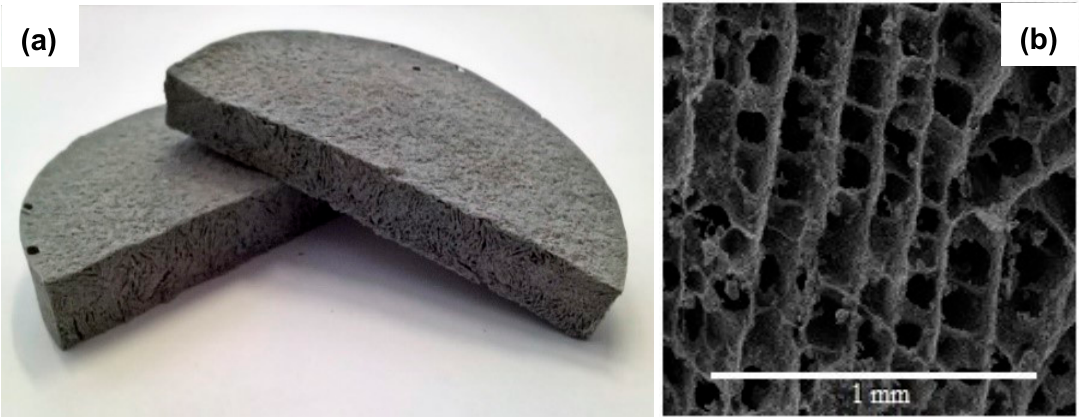
Figure 3. ( a ) Fiberglass foam; ( b ) fiberglass foam microstructure.